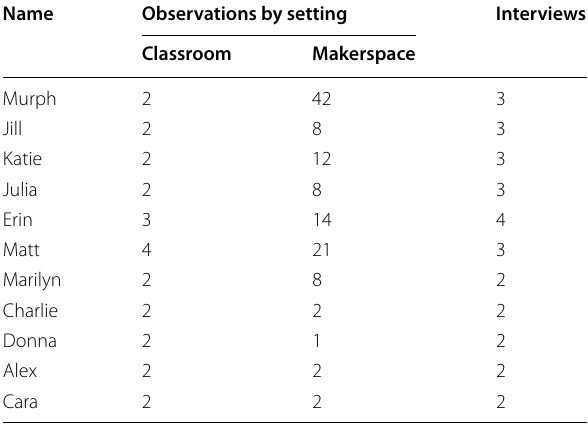
Observations do not include the week-long